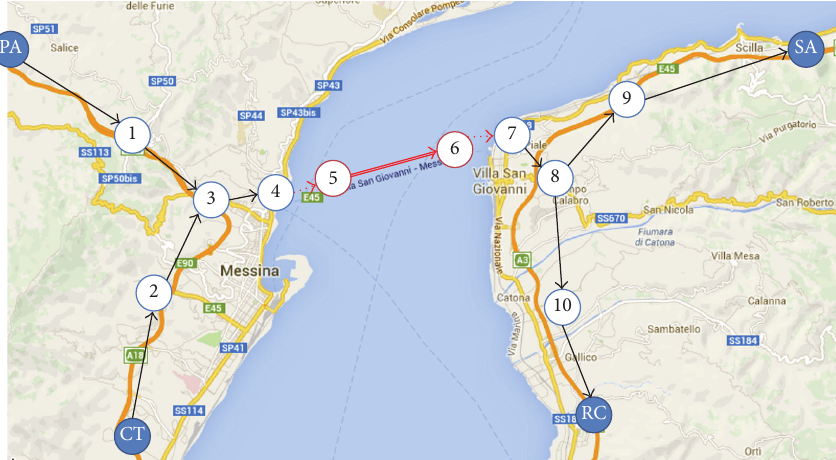
Figure 7: Test network on Strait of Messina (background image from